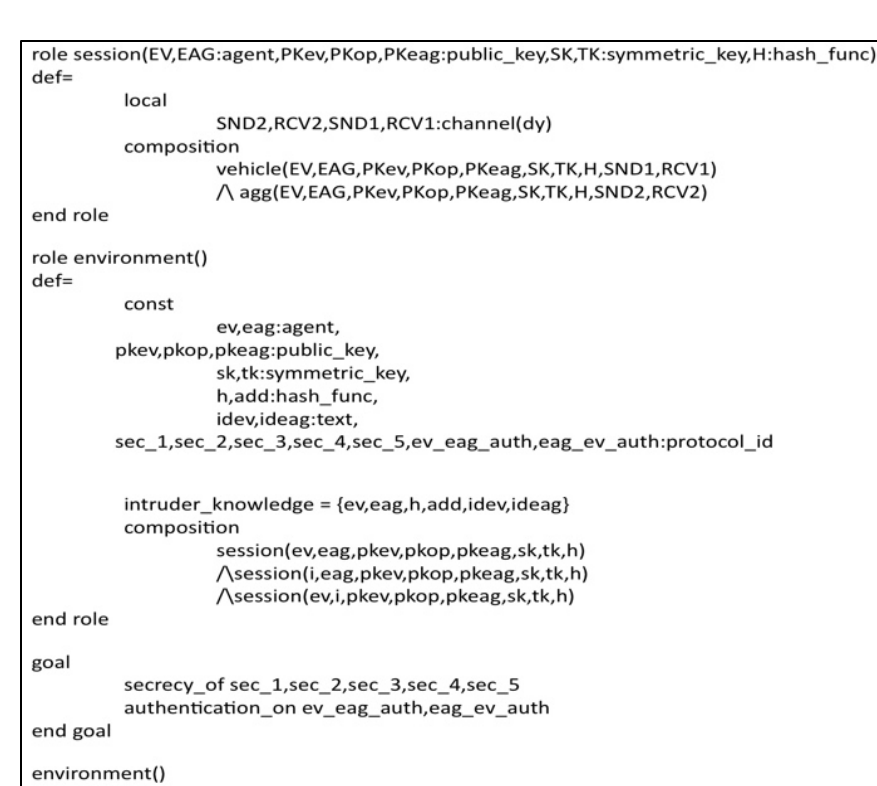
Figure 15. Reauthentication Specification of the session and environment.